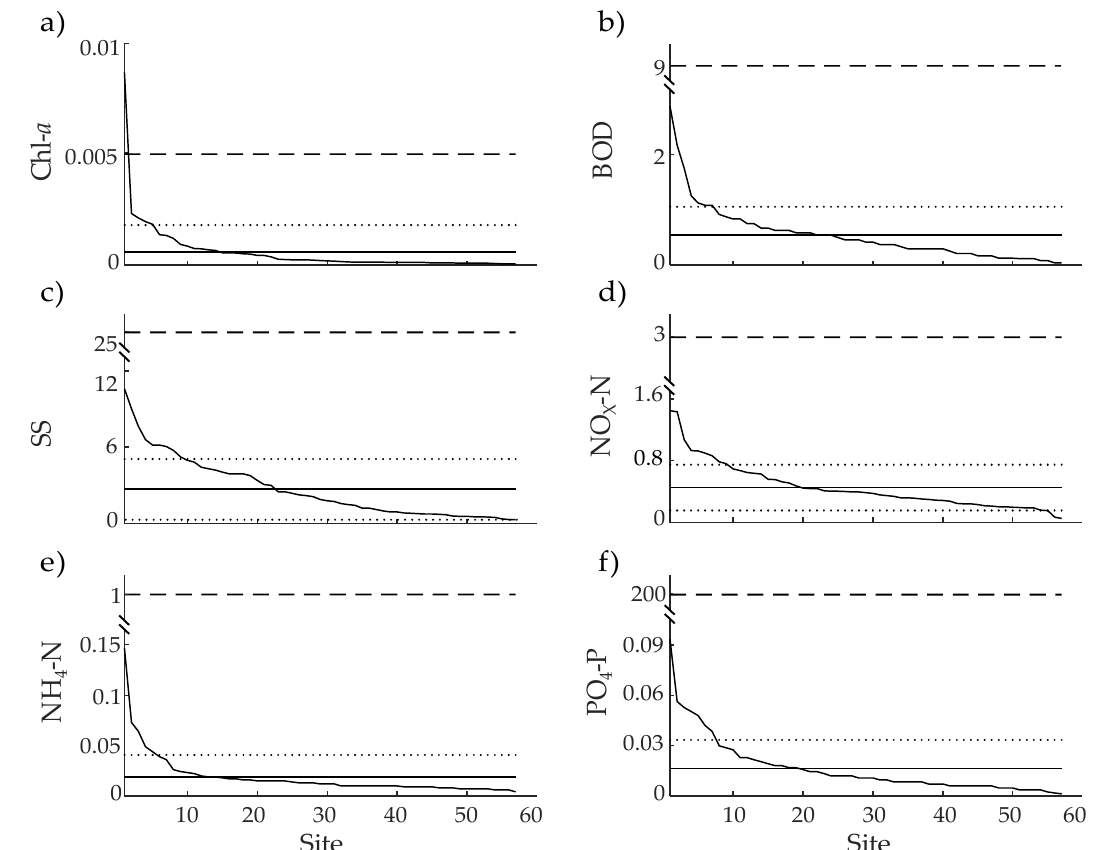
Figure A2. U-matrix based on SOM according to individual loci compositions in Hydropsyche albicephala ( a ); Stenopsyche marmorata ( b ); and Hydropsyche orientals ( c ). Color bars in the U-matrix indicate the mean Euclidean distance between the weights of nodes surrounding the U-matrix on the map.